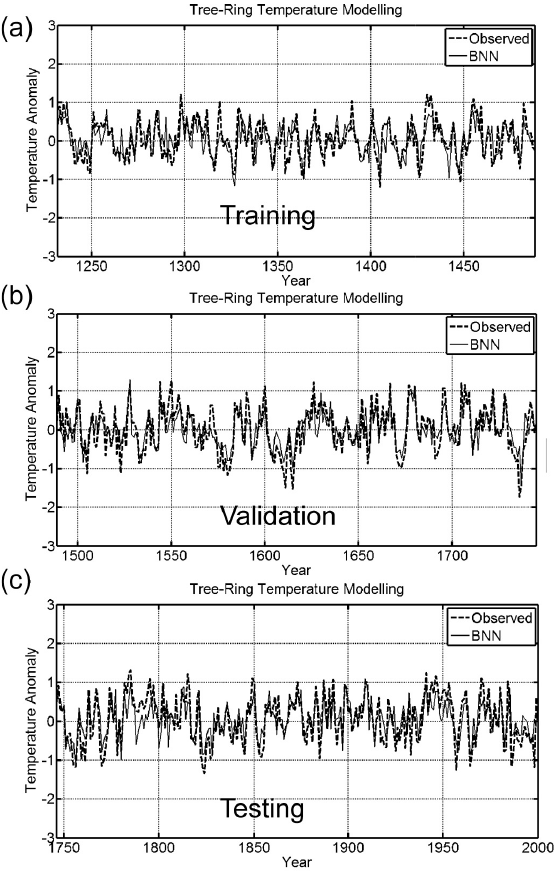
Fig. 9. One lag temperature anomaly reconstruction using Bayesian neural network in the period (a) AD1232–1488, (b) AD1489– 1745, (c)